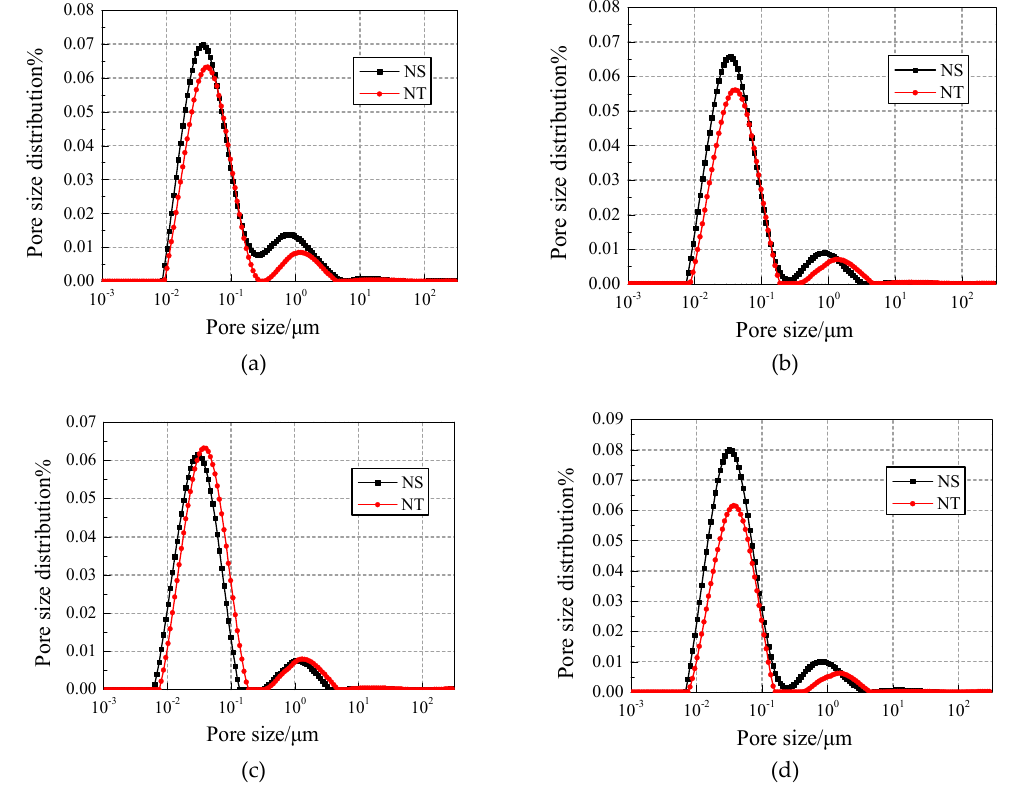
Figure 12. Comparison of pore fluid size distribution of NS/NT added concrete under 25 freezing and thawing cycles. ( a ) Content of 0.2%; ( b ) Content of 0.4%; ( c ) Content of 0.6%; ( d ) Content of 0.8%.